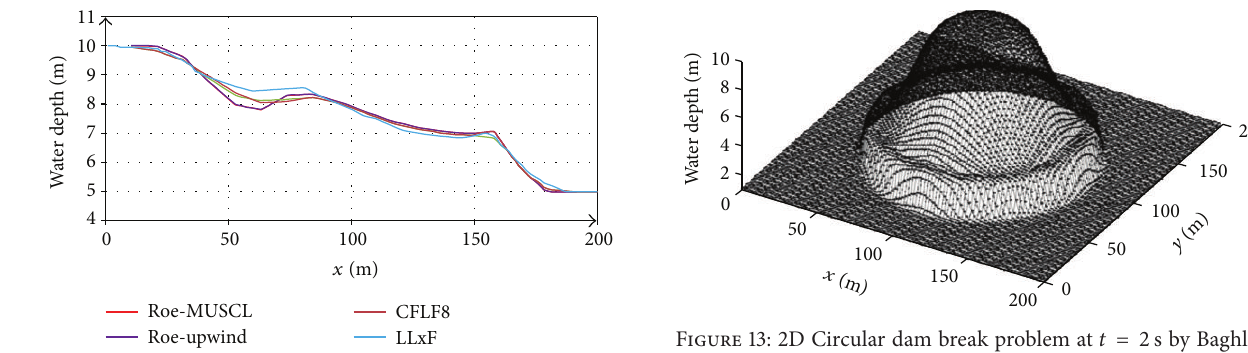
Figure 13: 2D Circular dam break problem at 𝑡 = 2 s by Baghlani